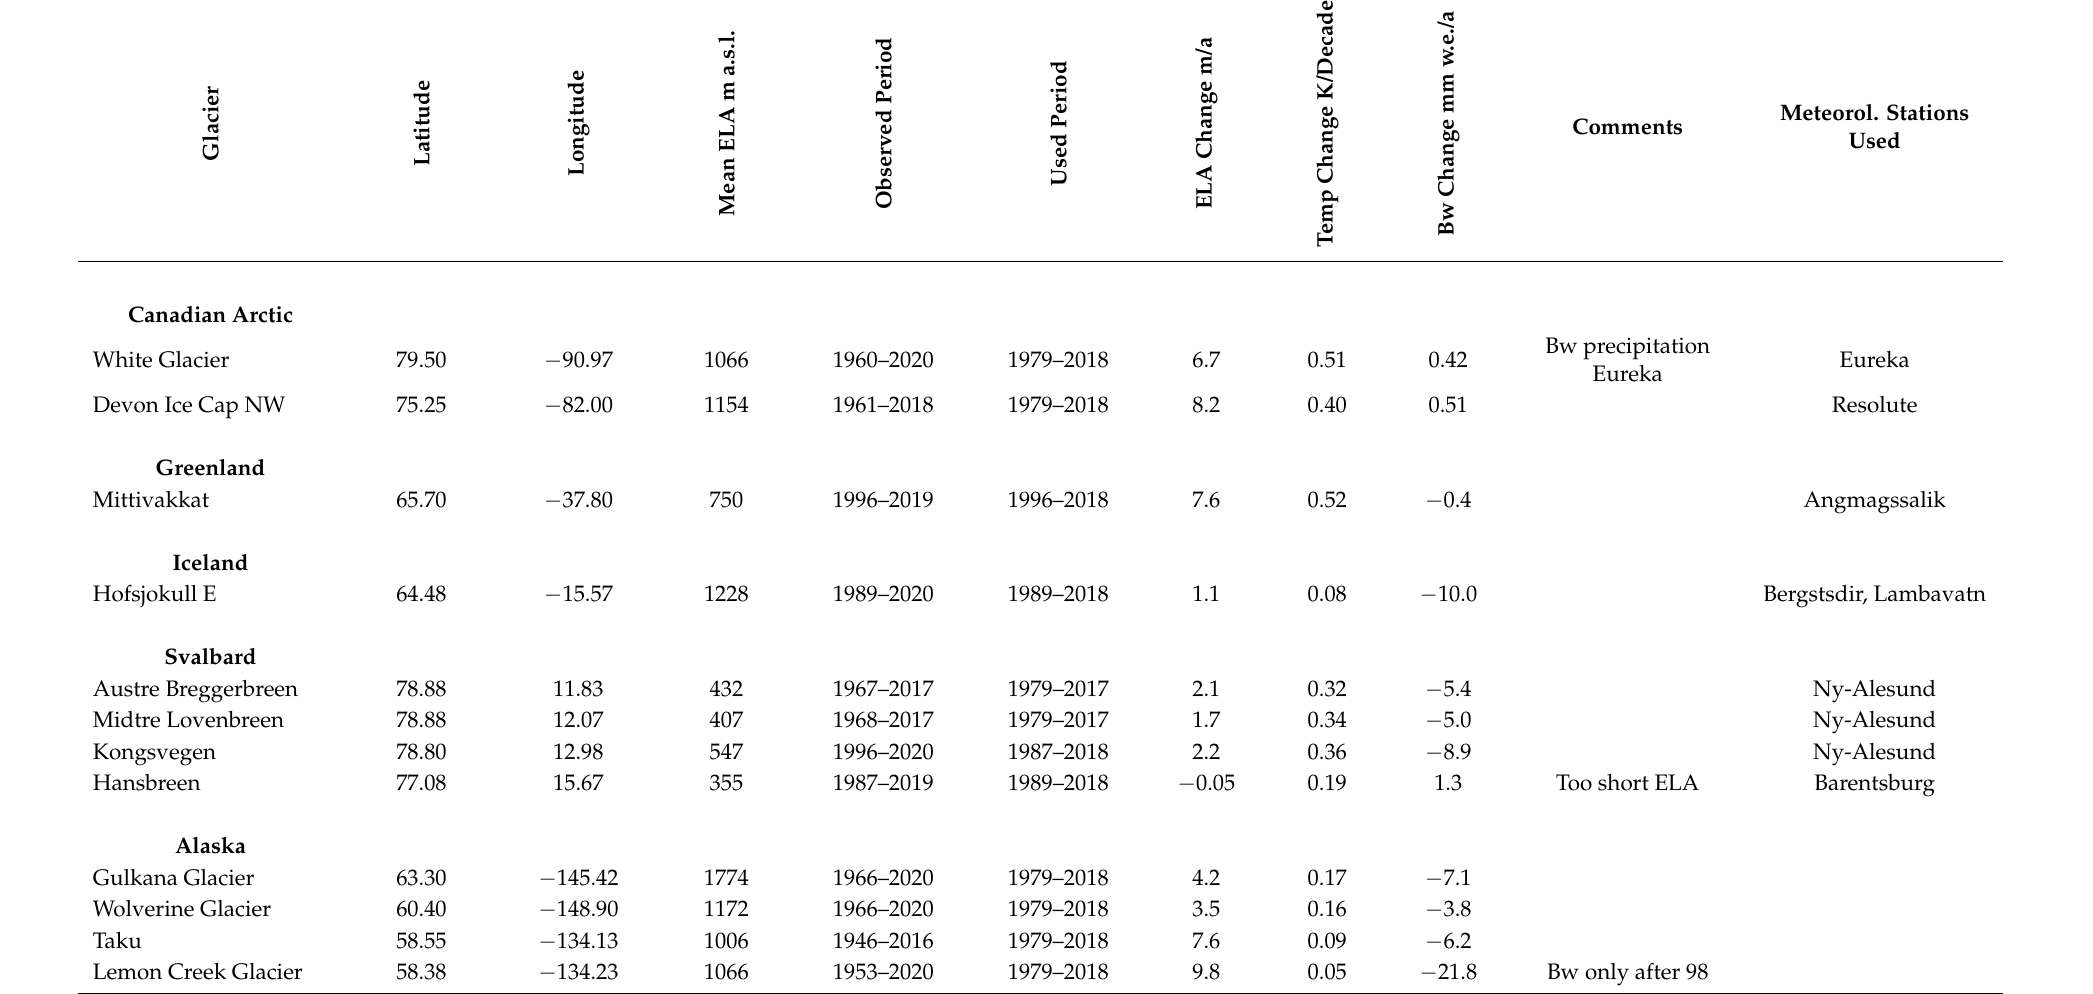
Table 2. The rates of changes: ELA shift (ma − 1 ), temperature (K/decade), and winter balance (mma − 1